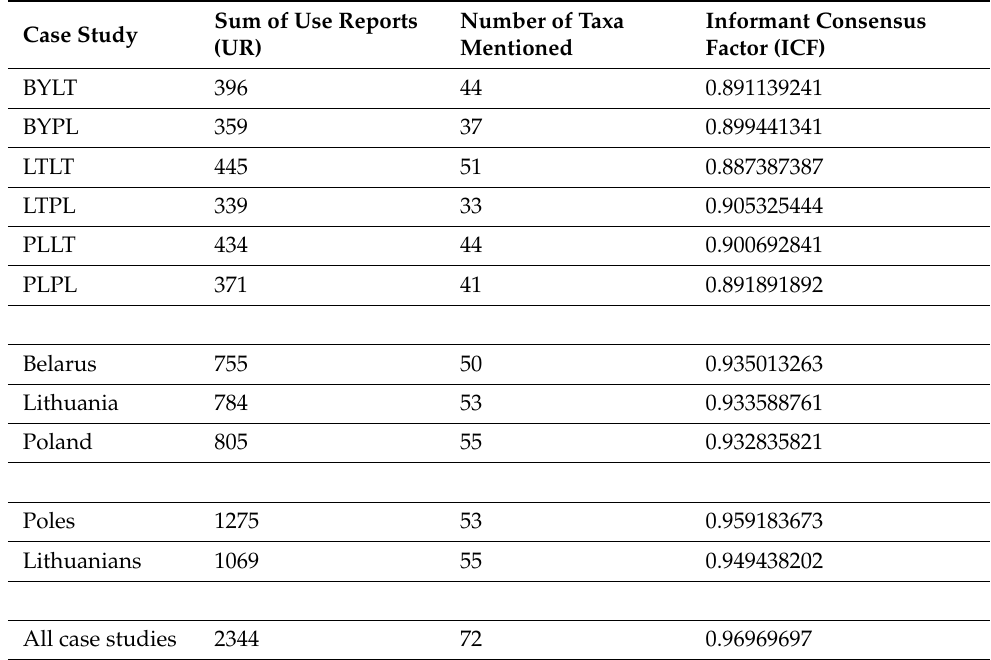
Table 5. Informant consensus